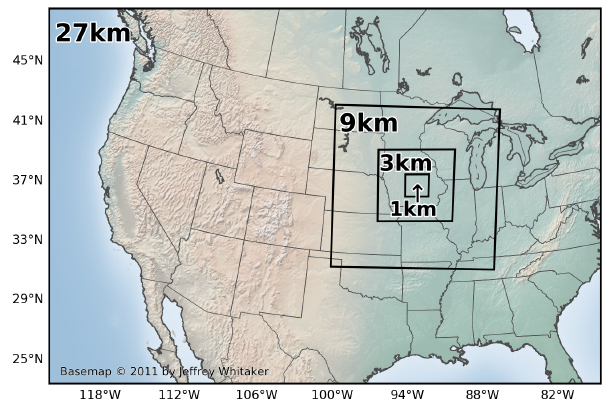
Figure 1. Map representing the domains (starting at 27km, nest- ing down to 9, 3, and 1km) of the horizontal resolution tests that also serve as the outer domains for finer resolutions. Geography data provided by Matplotlib’s (Hunter, 2007) Basemap © 2011 by Jeffrey Whitaker.